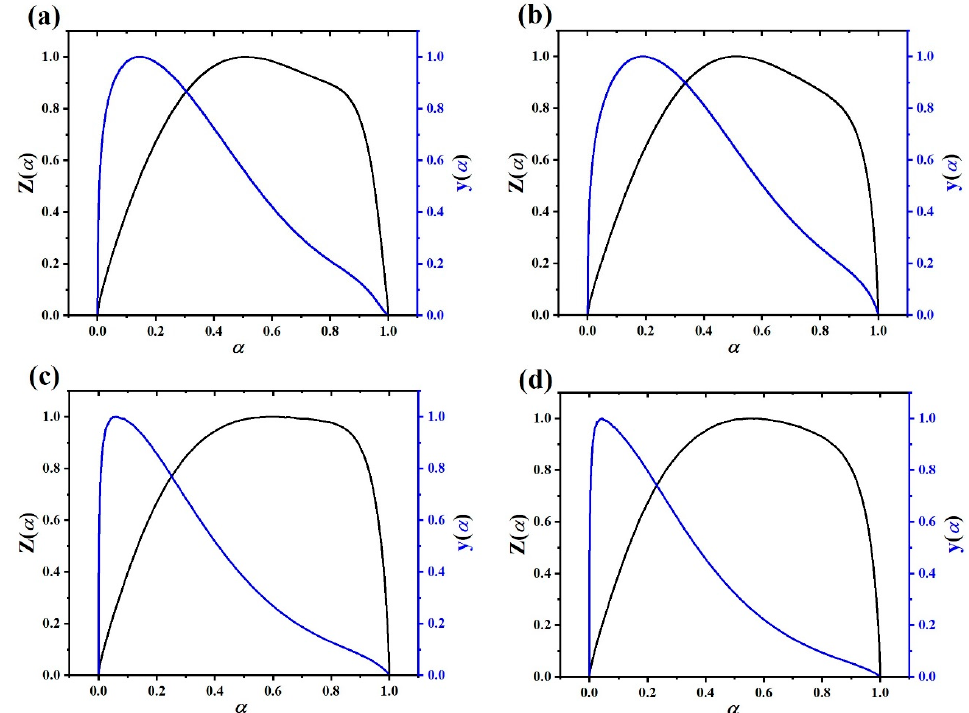
Figure A4. Variation of y ( α ) and z ( α ) versus conversion for prepared samples based on Malek model for ( a ) neat epoxy, ( b ) E-0.1AHP, ( c ) E-0.3AHP and ( d ) E-0.5AHP.